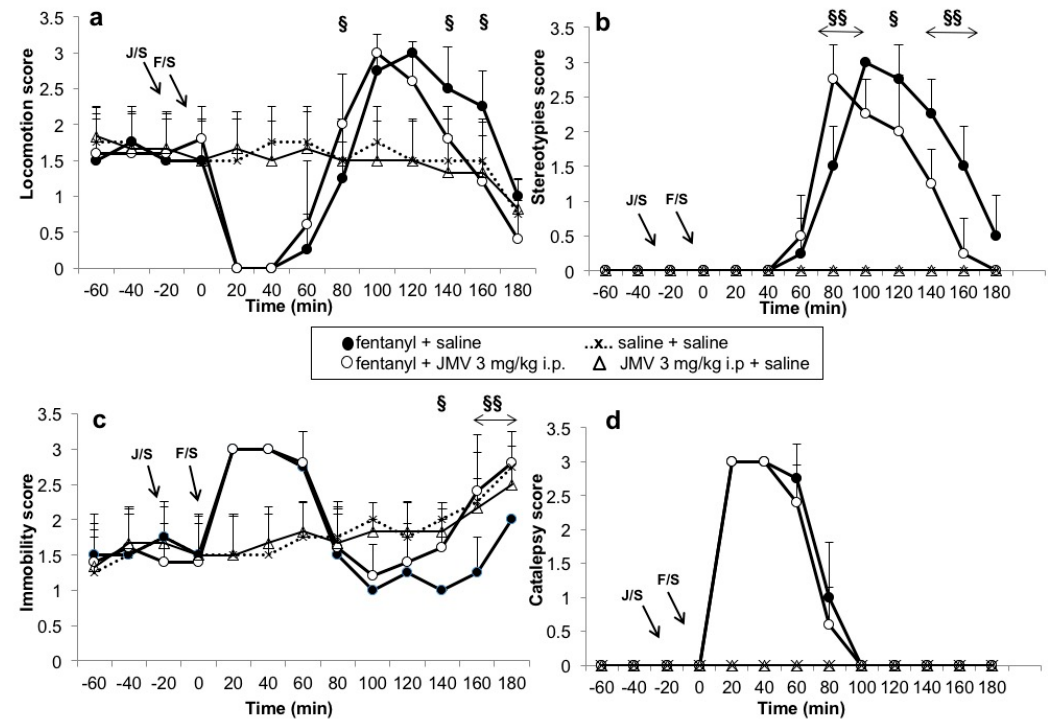
Figure 7. Effects of ghrelin receptor antagonist JMV2959 (3 mg/kg i.p.) on behavioural changes